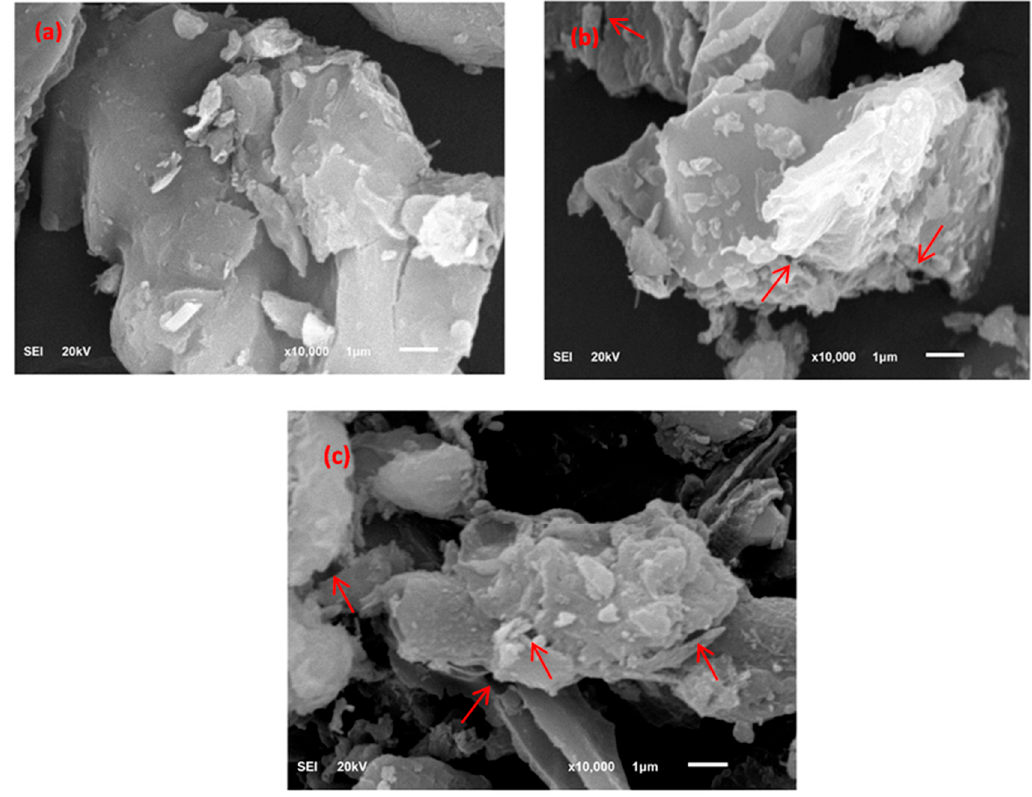
Figure 3. FE-SEM images of ( a ) palm leaves, ( b ) UBC and ( c ) TBC-P.